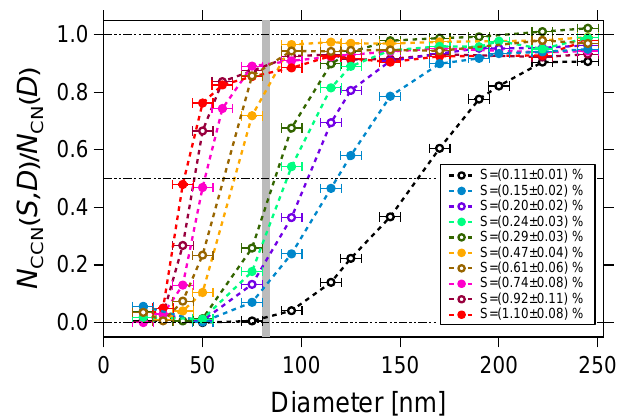
Figure 2. CCN activation curves for all measured S lev- els ( S = 0.11–1.10%), averaged over the entire measurement period. Data points represent arithmetic mean values. For N CCN ( S,D)/N CN ( D ), the standard error is plotted, which is very small (due to the large number of scans with comparatively small variability) and therefore not perceptible in this representation. For the diameter, D , the error bars represent the experimental error as specified in Sect. 2.3. The grey vertical band represents the posi- tion of the Hoppel minimum (including error range) for the annual mean number size distribution (compare to Fig. 3). Dashed lines provide visual orientation and indicate 0, 50, and 100% activation. The value at 50% activation is used for calculation of the hygro- scopicity parameter κ ( S , D a ) . The lines connecting the data points merely serve as visual